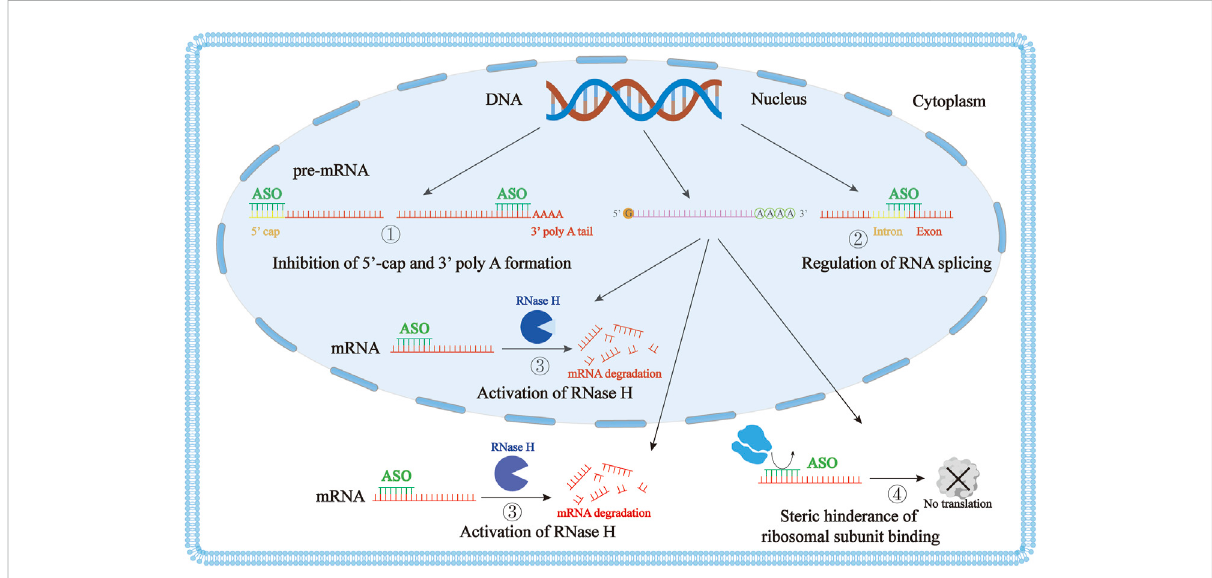
FIGURE 1 The mechanism of action of antisense oligonucleotide (ASO). ① ASO affects mRNA maturation by inhibition of the 5 ′ end cap formation or by blocking thepolyadenylation ofthe3 ′ end. ② ASO can selectively regulatethesplicing ofprecursormRNA. ③ ASO activates theRNaseH enzymeto degrade DNA-mRNA duplexes through cleavage. ④ ASO can prevent the interaction of RNA and ribosomes through steric hindrance, blocking the translation